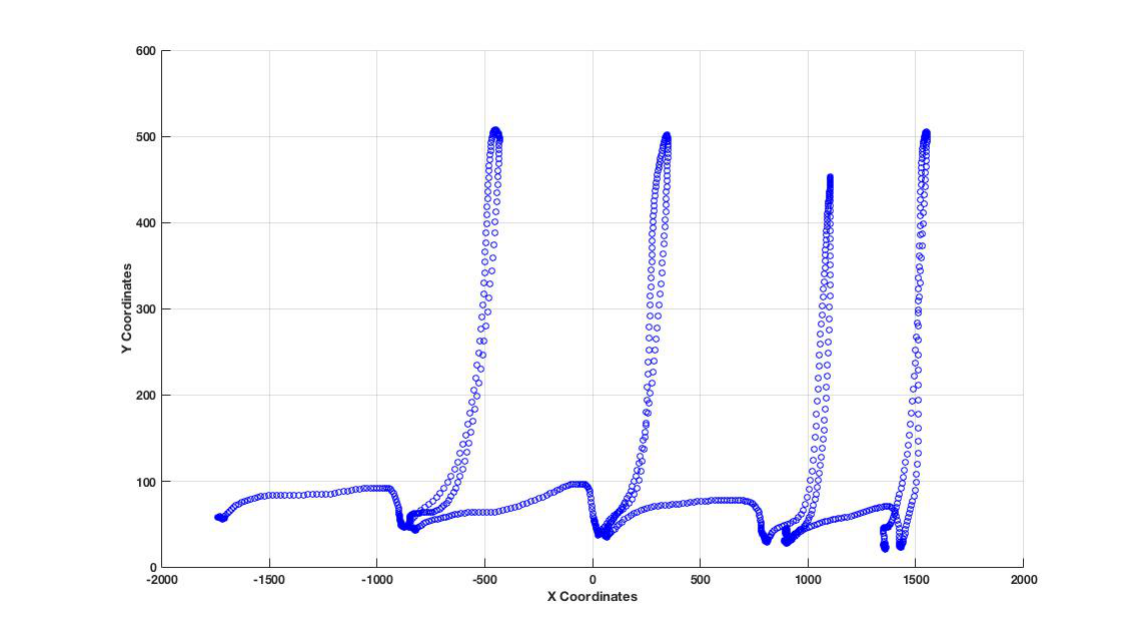
Figure 14. The coordinates of the trajectory of the left foot joint, which shows the rhythm of the dance performed by dancer 1.